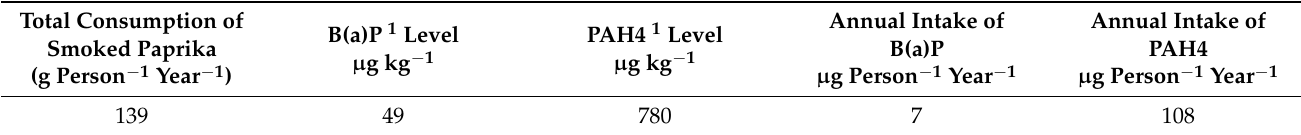
Table 4. Annual intake per person of PAHs ( µ g y -1 ) in Extremadura from the consumption of all kinds of processed meat products, cooked products and products seasoned with smoked paprika. Total Consumption of Smoked